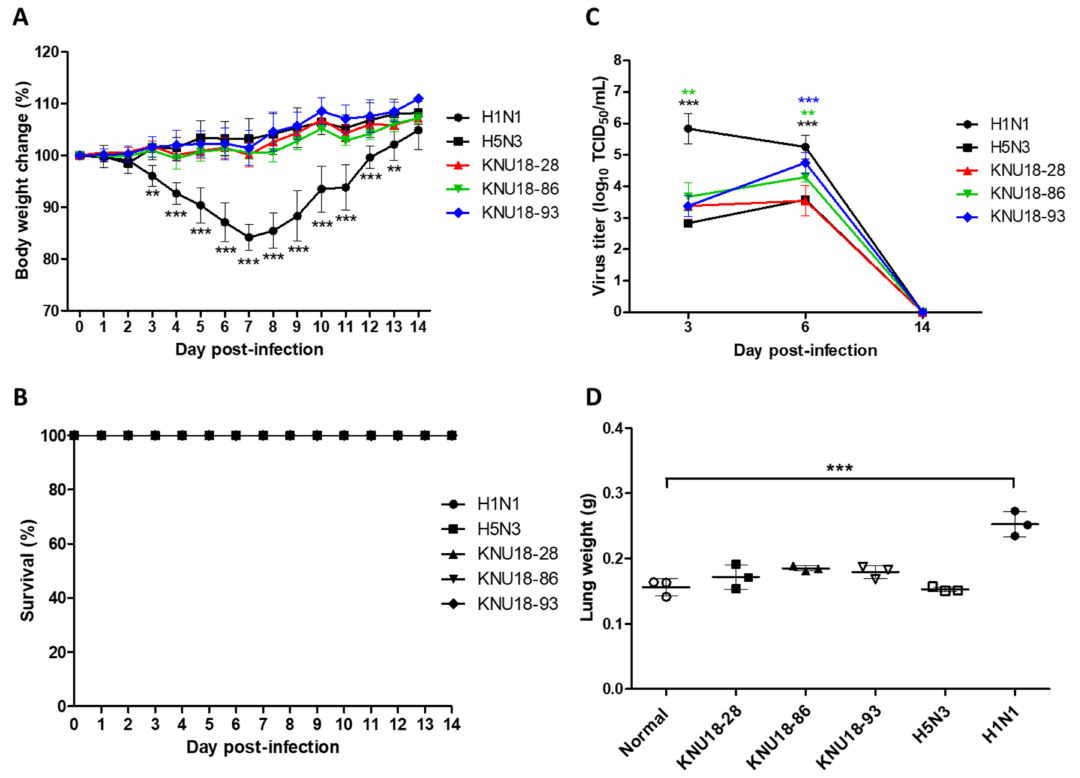
Figure 5. In vivo pathogenicity of three novel H5N2 isolates in mouse model. The BALB/c mice were intranasally challenged with three novel H5N2 isolates (KNU18-28, KNU18-86, and KNU18-93) at titer 10 5 EID 50 /mouse. H1N1 and H5N3 virus strains were used as controls. Mouse bodyweight change ( A ) and survival rate ( B ) were observed for 14 days post-infection (dpi). Bodyweight is presented as a % change from those of the same mice at day 0 ( n = 5). ( C ) The viral titer mean values in the mouse lung ( n = 3) were determined at 3, 6, and 14 dpi. ( D ) Mean lung weight of normal mice and infected mice at 6 dpi ( n = 3) was observed before examining the histology of lung inflammation by hematoxylin and eosin (H&E) staining. **, p < 0.01; ***, p <